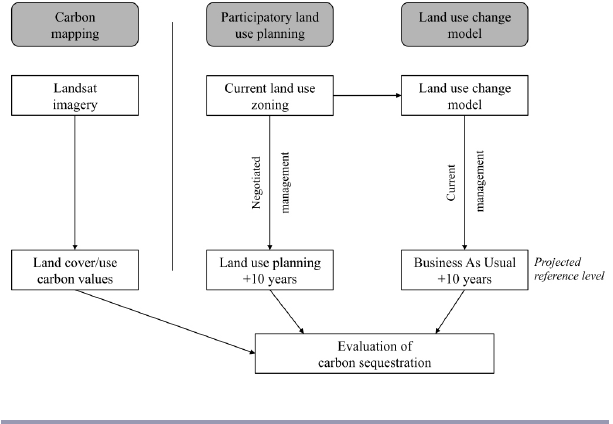
Fig. 2. Land-cover/use map 2009 (a) and carbon stock values 2009 (b) for the study